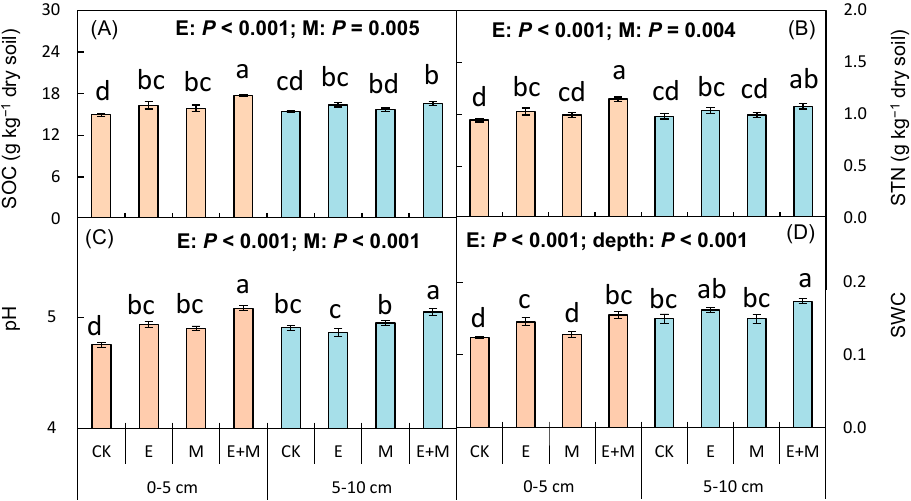
Figure 1. Soil properties after the addition of earthworms and millipedes to two soil layers. CK, control; E, earthworm addition; M, millipede addition; E + M, earthworm addition + millipede addition. ( A ) SOC: soil organic carbon (g · kg − 1 dry soil); ( B ) STN: soil total nitrogen (g · kg − 1 dry soil); ( C ) pH: soil pH; ( D ) SWC: soil water content (ratio of water to dry soil). Data represent means ± SE (n = 5). Significant ( p < 0.05) effects based on one-way ANOVA are presented by lowercase Table 1. E ff ects of earthworm addition (E), millipede addition (M), and soil depth (depth) on soil properties, soil nematode abundance, and diversity.